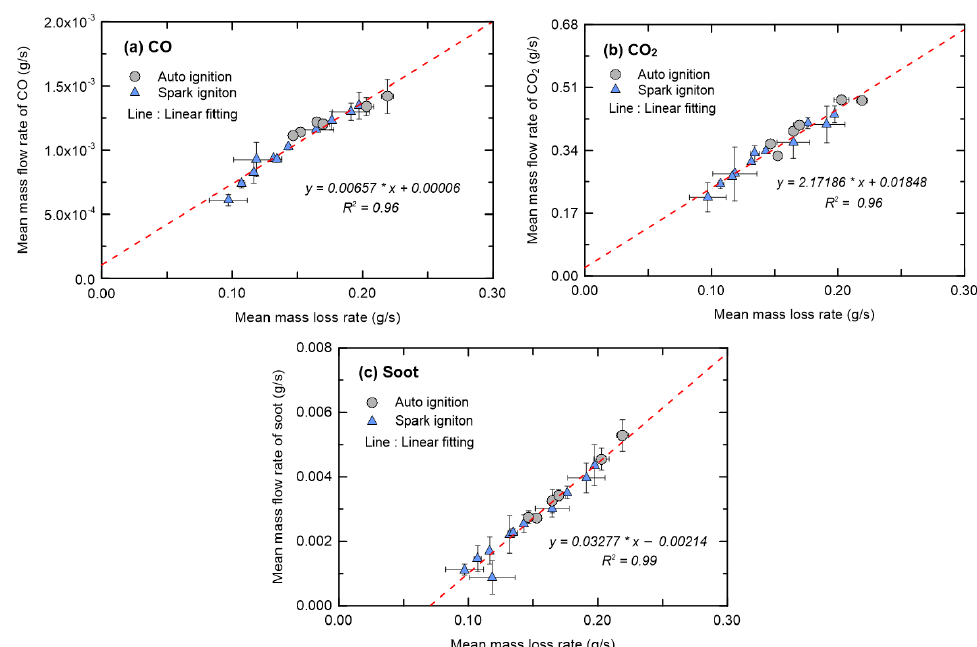
Figure 8. Mean mass flow rates of CO, CO 2 , and soot as a function of mean mass loss rate.